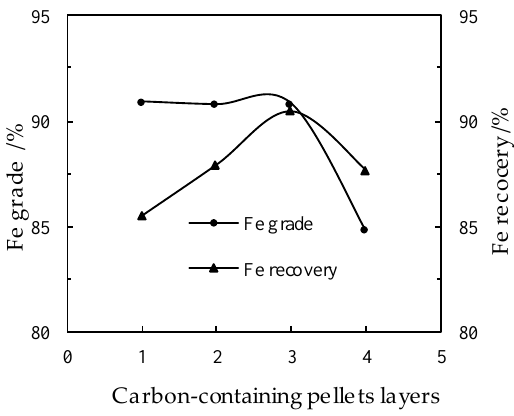
Figure 7. Effect of carbon-containing pellets layers on the DR process.